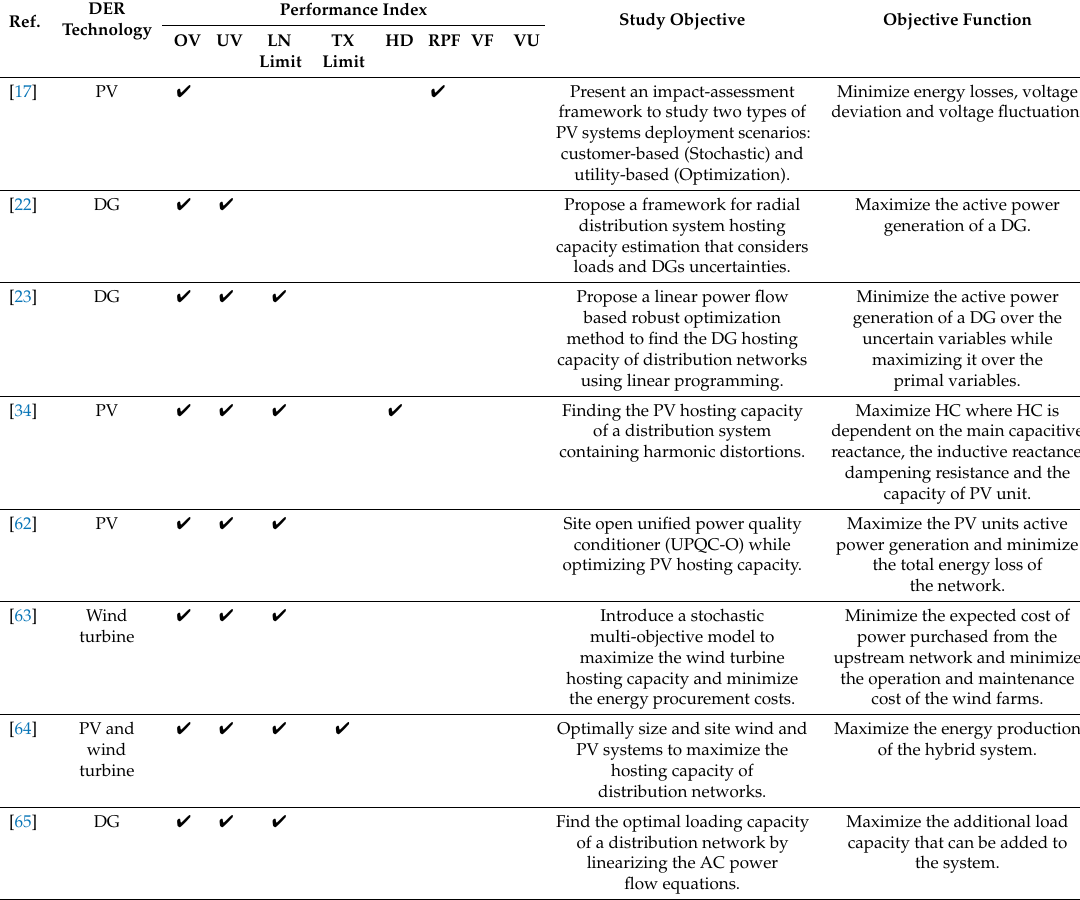
Table 4. Studies that utilize the optimization-based method for hosting capacity evaluation. Ref.